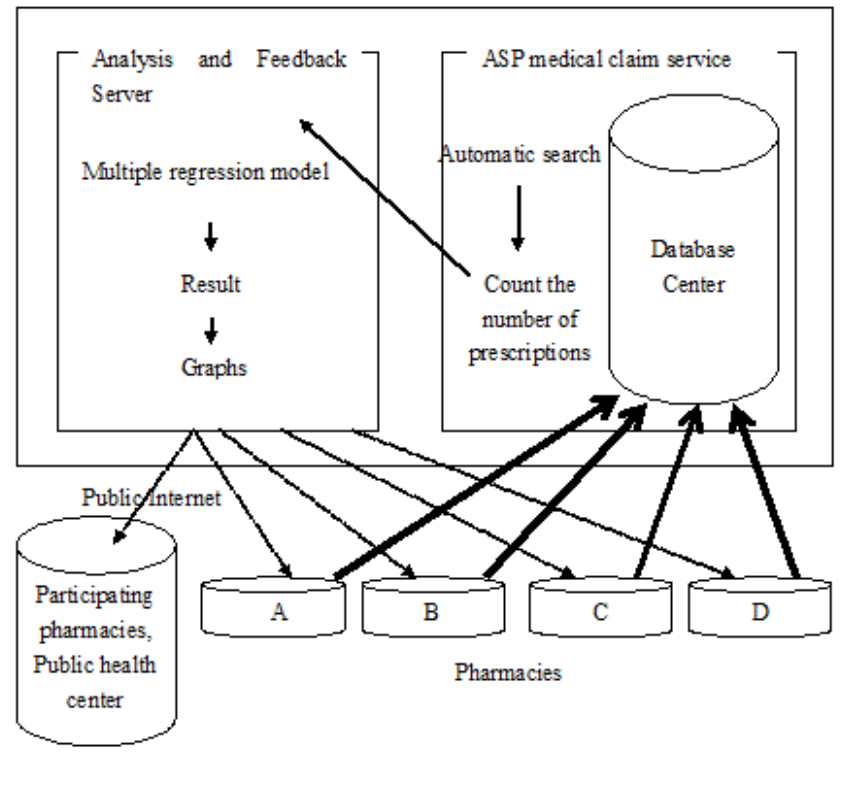
Figure 1. Prescription surveillance. Pharmacies A–D use the application service provider’s (ASP) medical claims service. All data are stored in a central database. The surveillance system automatically counts oseltamivir, zanamivir, and laninamivir prescriptions at the data center. The information is analyzed using multiple regression models. The results are presented as figures and tables and feedback to participating pharmacies as well as public health